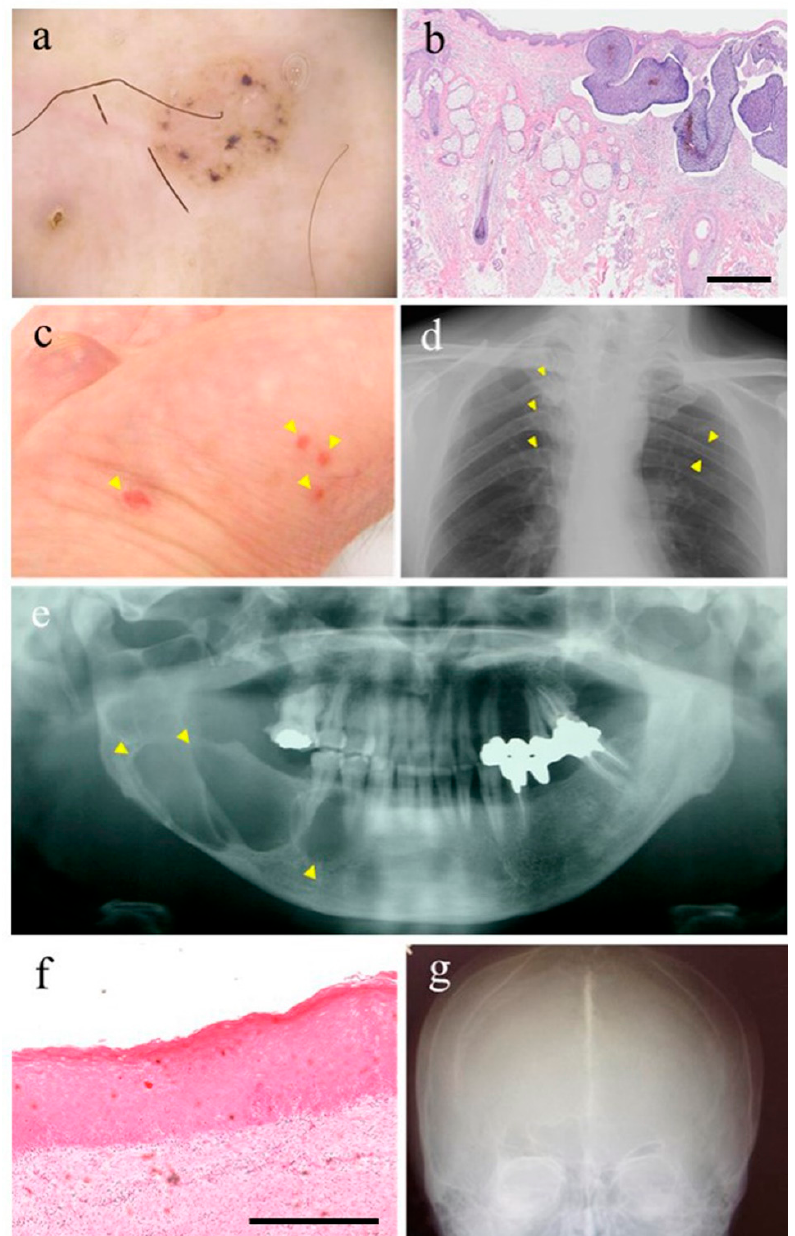
Figure 1. Characteristic features of Gorlin syndrome: ( a ) dermoscopic features of Basal cell carcinoma (BCC); ( b ) pathological phenotype of BCC. Scale bar:50 μ m; ( c ) multiple palmar pits are indicated by yellow arrowheads; ( d ) rib anomalies such as bifidity and splaying are indicated by yellow arrowheads; ( e ) keratocystic odontogenic tumor are indicated by yellow arrowheads (OKC); ( f ) pathological phenotype of OKC. Scale bar:50 μ m; ( g ) falx calcification.